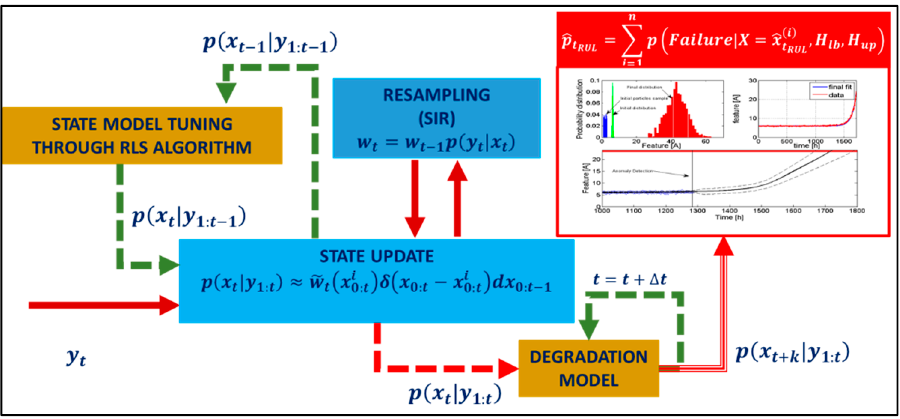
Figure 9. Flowchart of the prognostic algorithm.